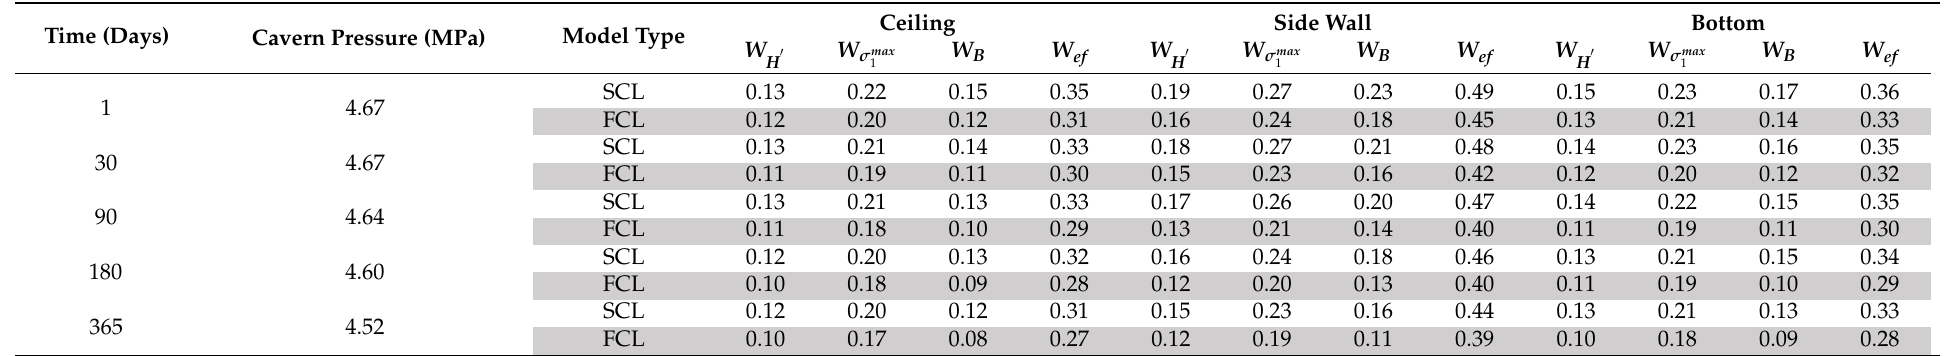
Table A2. Strength criteria for the two salt-creep models. Status at the end of the emptying cycle (after 6 h of cavern rest under minimum pressure). Time